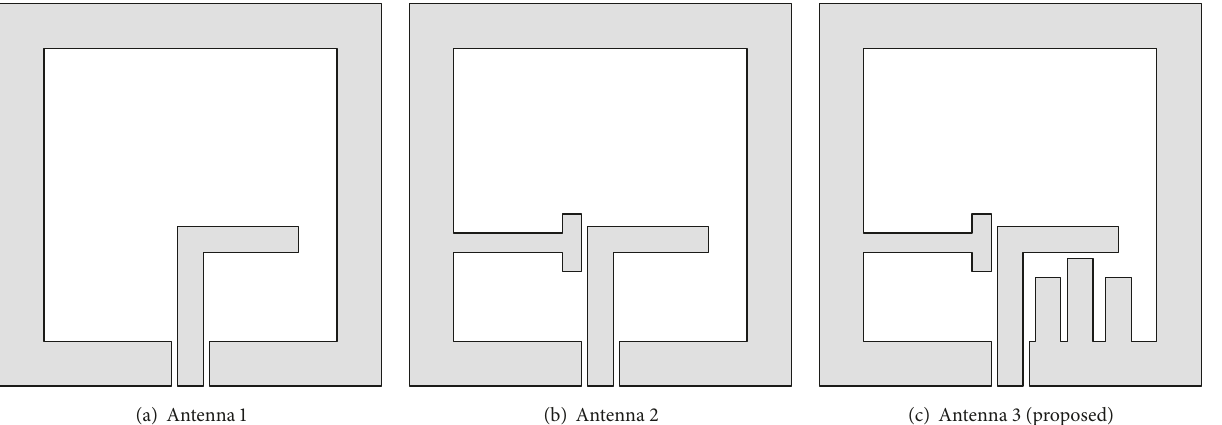
Figure 3: Three steps in the antenna design process.